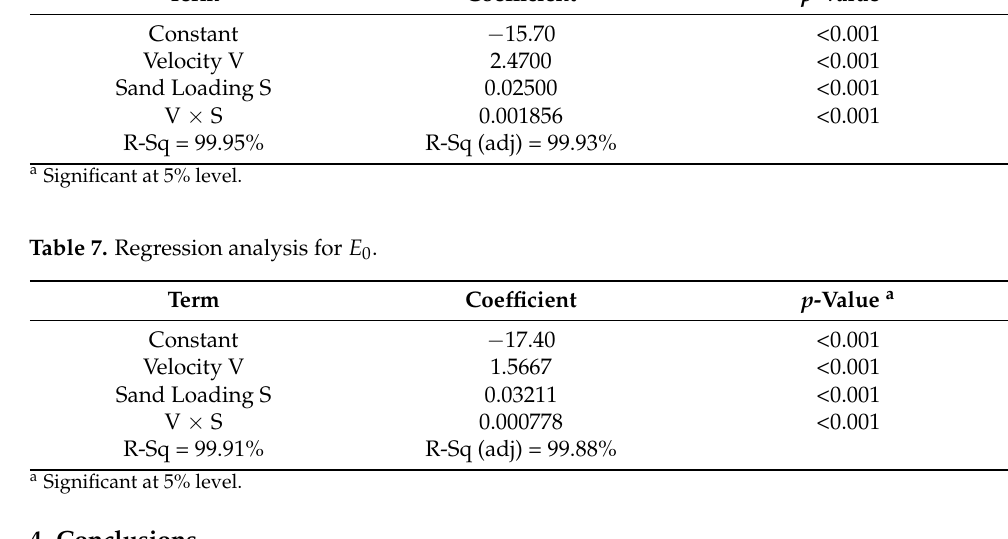
Table 6. Regression analysis for 𝑇𝑊𝐿 .